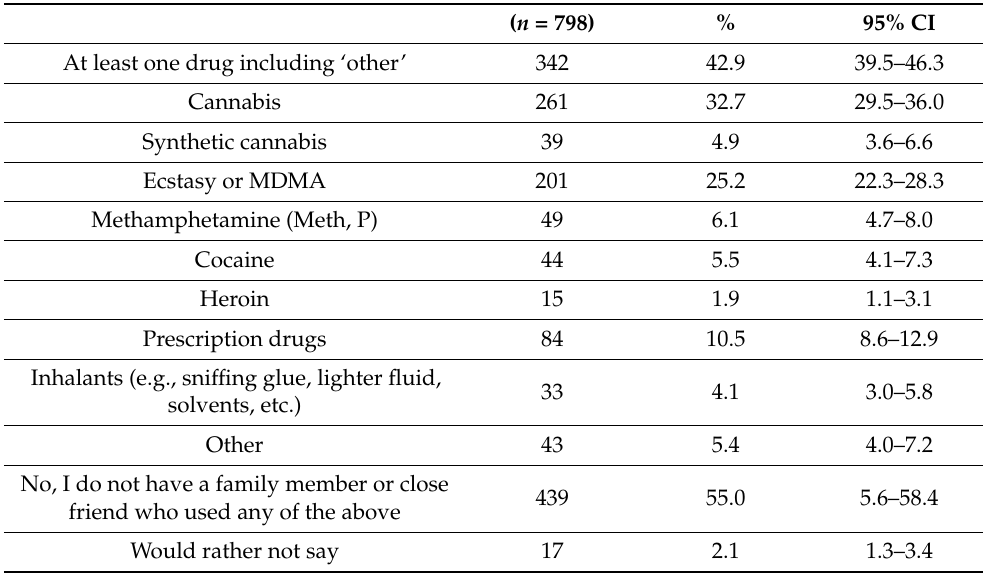
Table 4. Respondents who had family/wh¯anau member or close friend who used drugs in a harmful